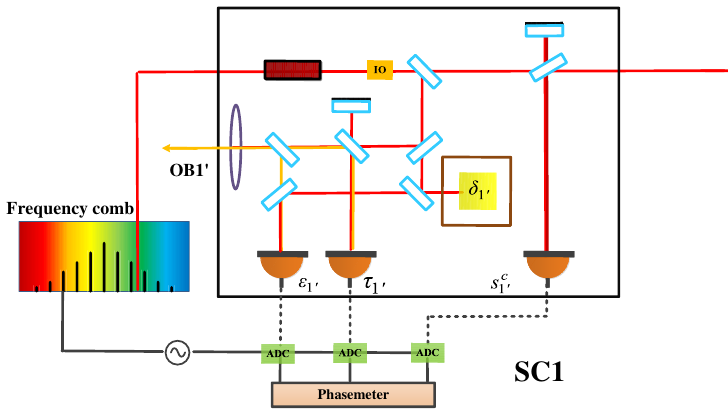
Figure 6. Space-borne optical interferometer with